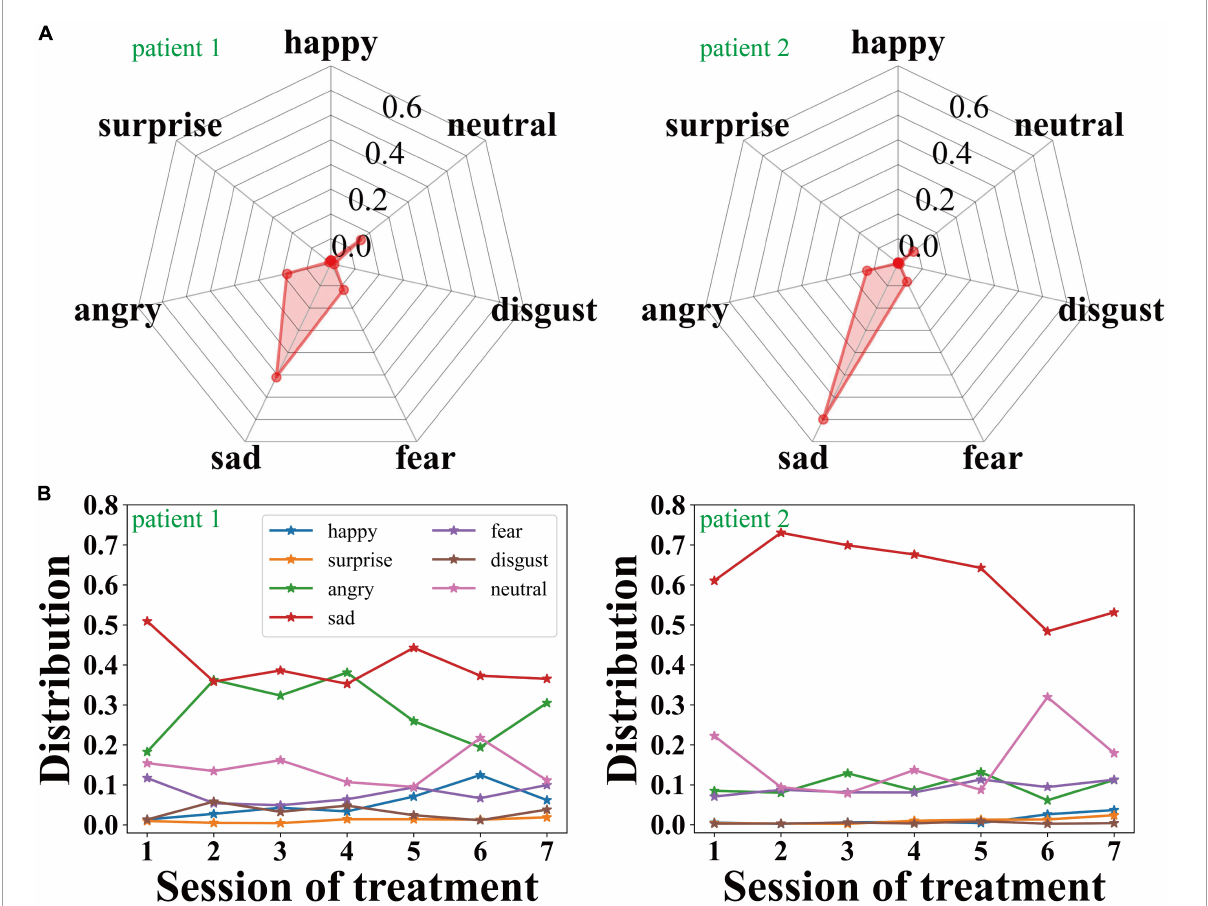
FIGURE3 (A) The expression feature distributions of the two selected patients during the second session of treatment, and (B) the change of the expression features of the two selected patients with the sessions of